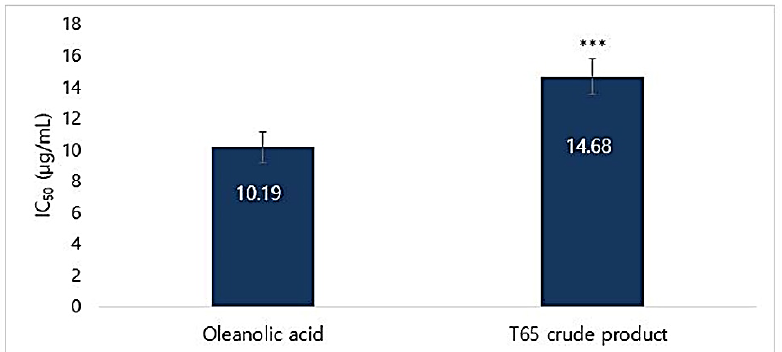
Figure 7. IC 50 of porcine pancreatic elastase (PPE) inhibition using T65 crude product and oleanolic acid. Data are given as mean ± SEM. Statistical significance is shown by ANOVA (*** p < 0.001).